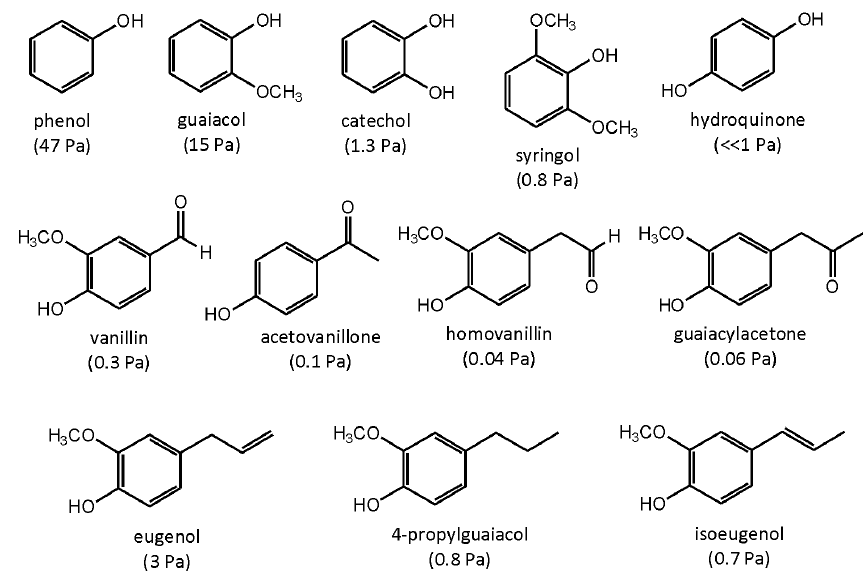
Fig. 1. Prevalent lignin pyrolysis products with vapor pressures listed in parentheses.